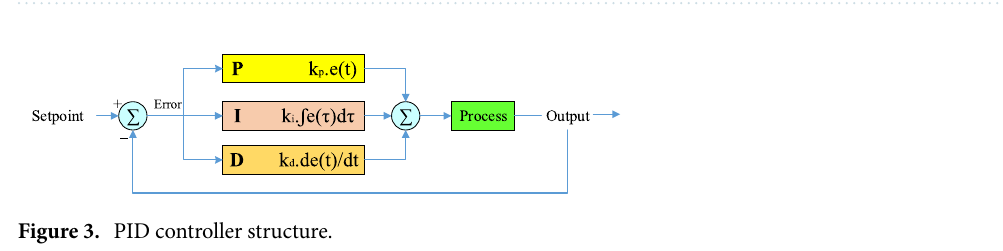
Figure 2. System frequency, ( a ) without a primary controller, ( b ) with a primary controller.